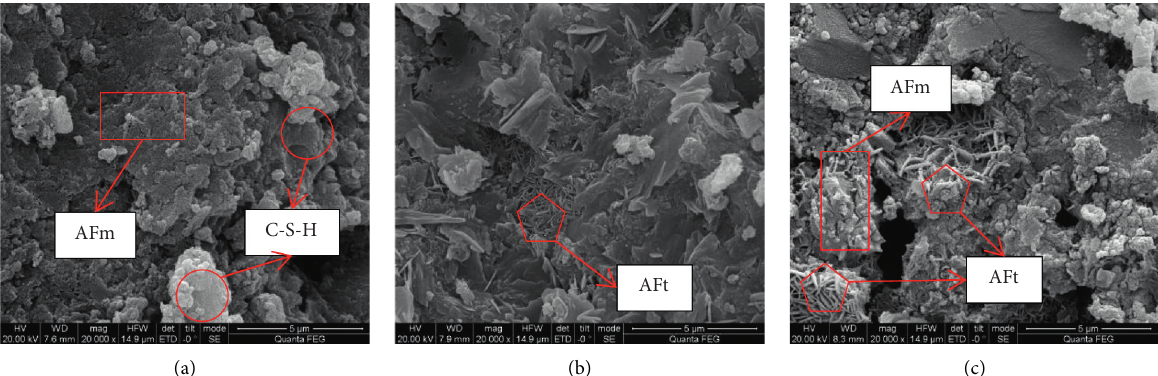
Figure 8: The micromorphology of the new material at different curing ages. (a) Curing for three days, (b) curing for seven days, and (c) curing for sixty days.